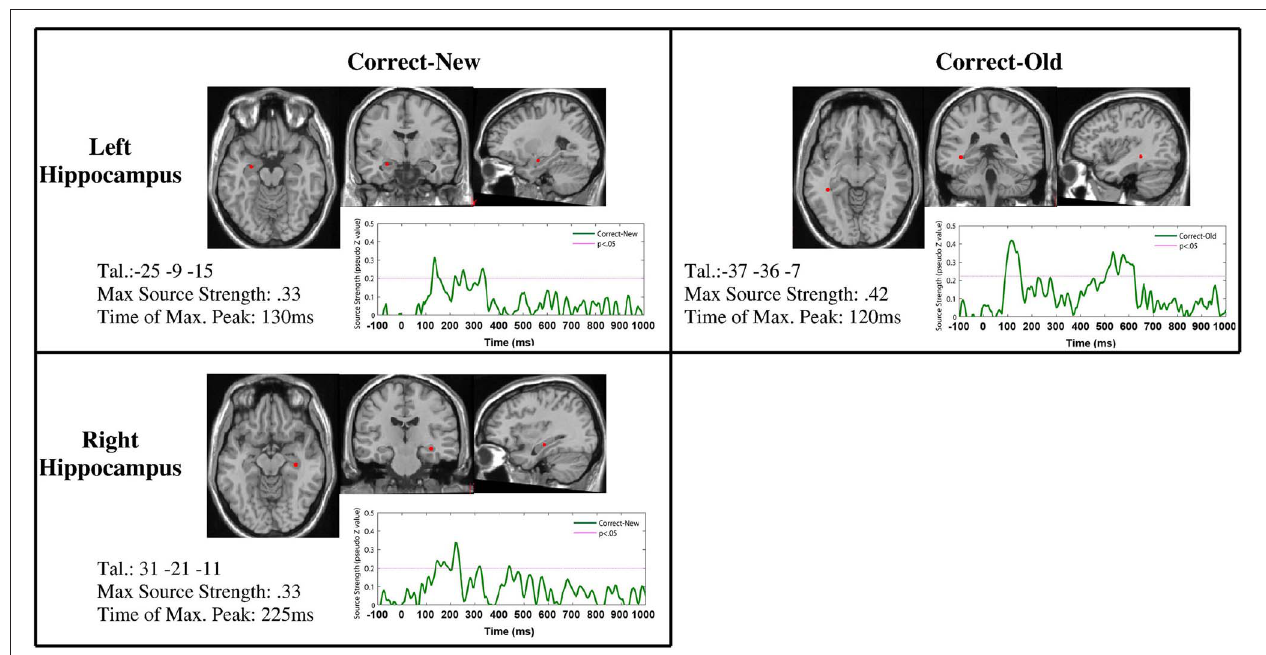
FIGURE 4 | Early ( ∼ 150ms post stimulus onset) hippocampal response detected with MEG. Reprinted from Riggs et al. (2009), Copyright (2009), with permission from